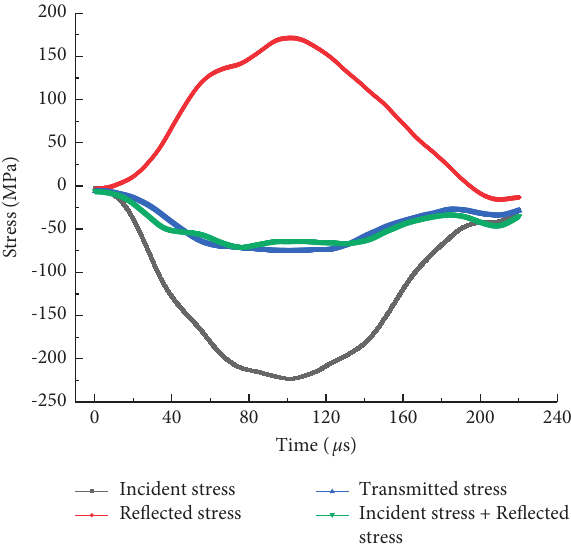
Figure 4: Verification of dynamic stress balance for a typical